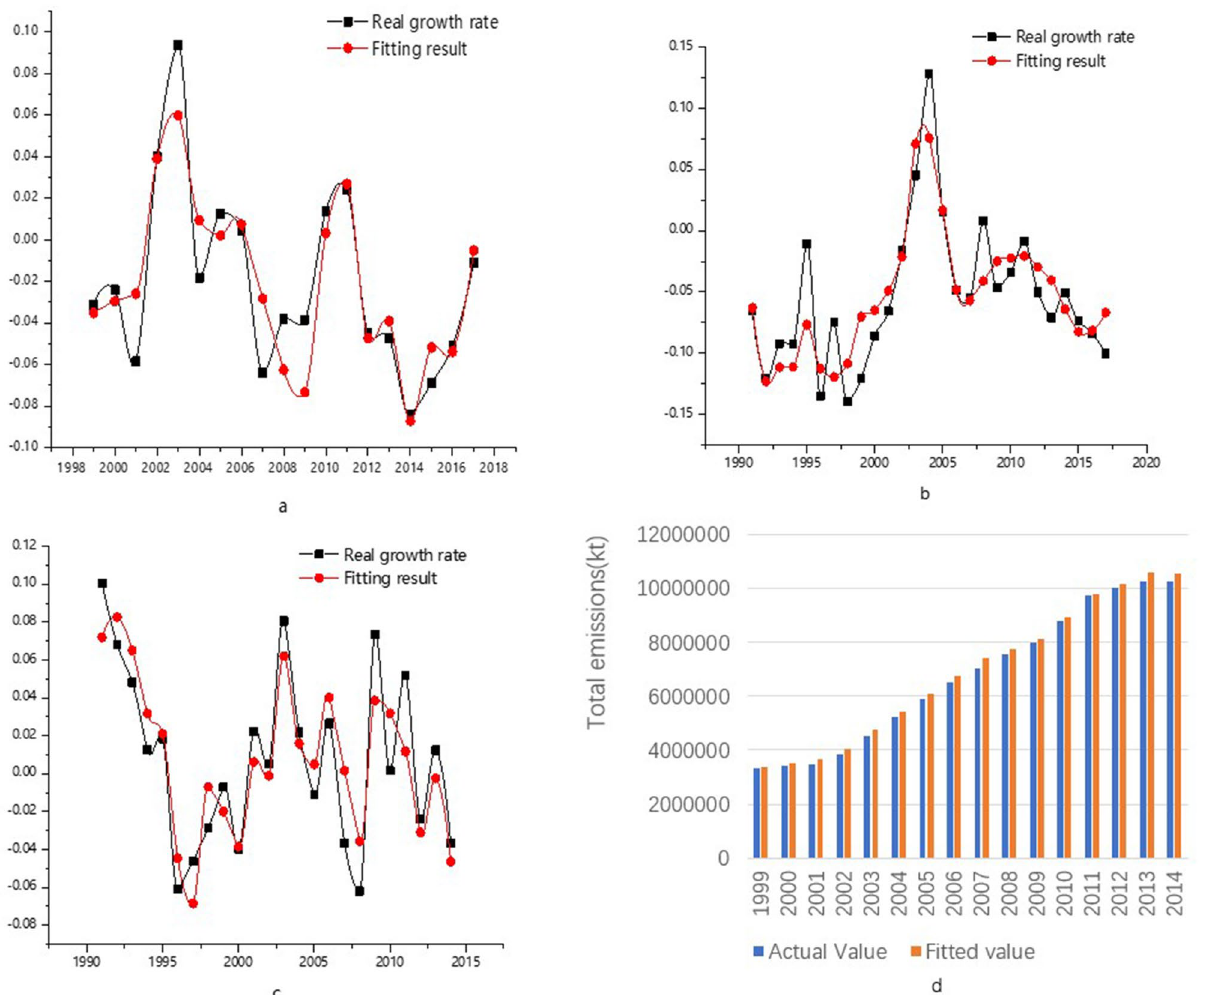
Figure 3. Regression analysis results [( a ) energy industry, ( b ) fuel combustion in other industries, ( c ) industrial production, ( d ) total emissions]. (Data source: performance of modelling).